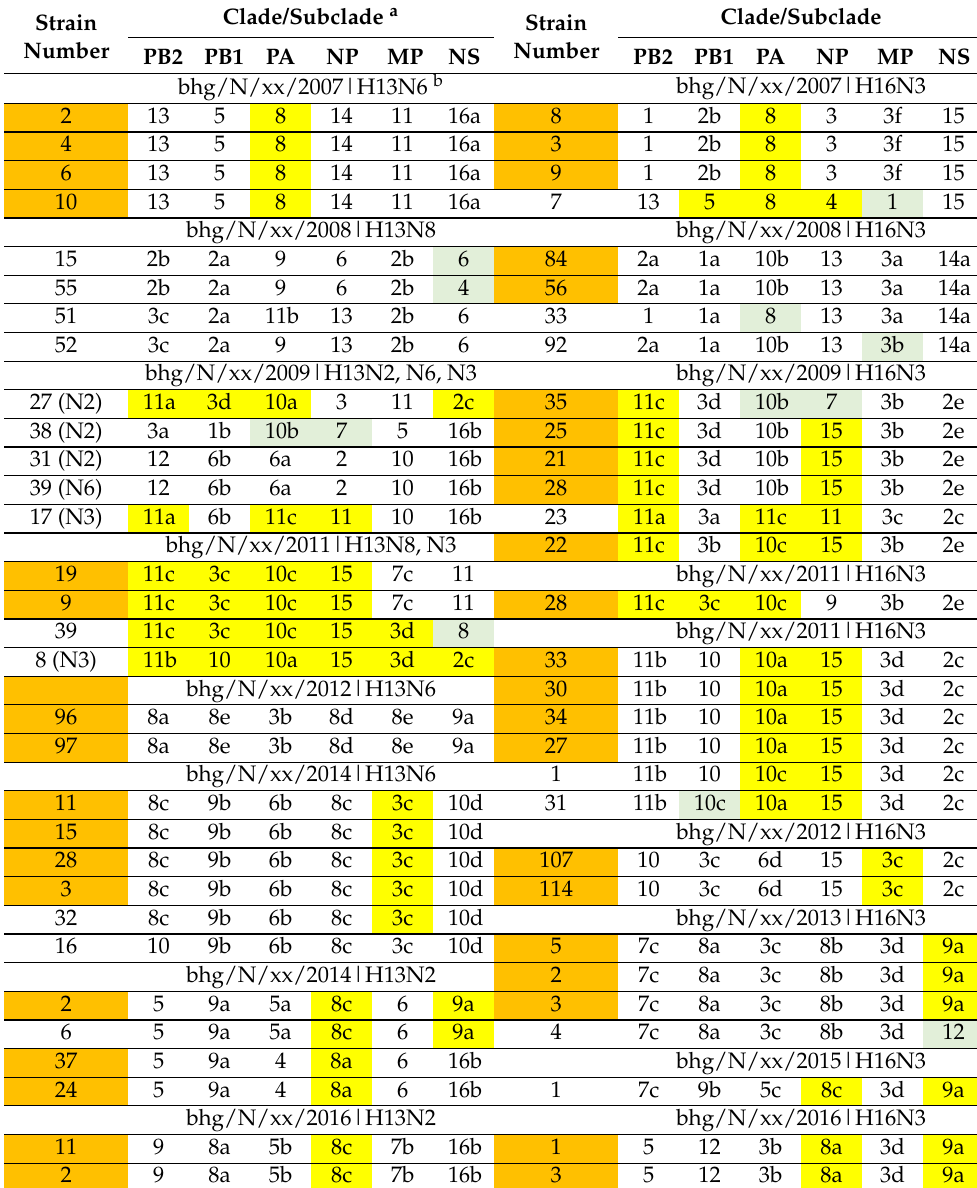
Table 3. Genome constellations of IAVs isolated in The Netherlands from black-headed gulls in the years